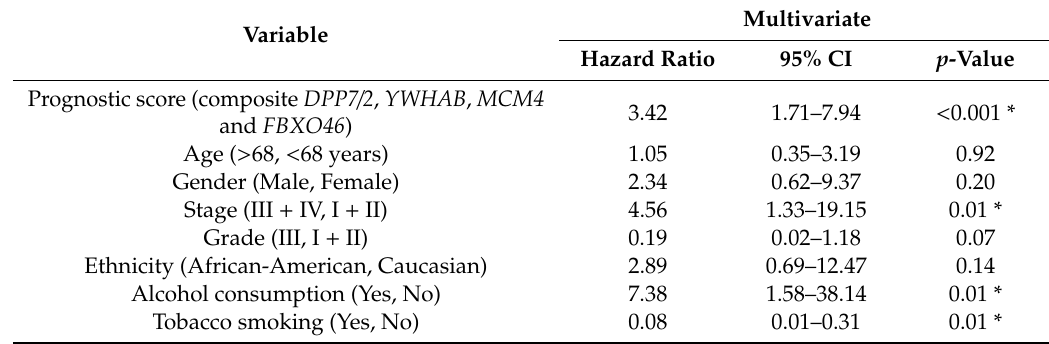
Table 5. Multivariate Cox regression analysis of prognostic score in combination with other clinicopathological